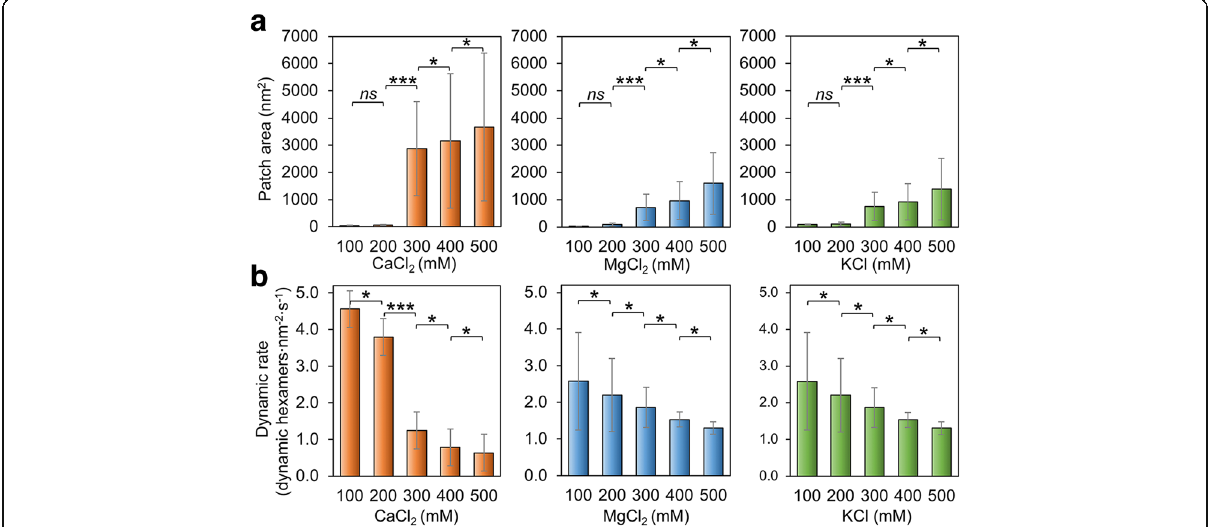
Fig. 3 Effects of salt concentration on the self-assembly of Hoch_5815. a The mean patch areas measured by AFM under a range of 100 – 500 mM CaCl 2 , MgCl 2 , and KCl ( n = 50). The rise in salt concentration resulted in increased patch sizes. Significant changes in patch area were observed between 200 and 300 mM (*** p < 0.001, * p < 0.05, ns not significant, two-way ANOVA). b The mean rates of dynamic events determined from high-speed AFM image series under a range of 100 – 500 mM CaCl 2 , MgCl 2 , and KCl ( n = 50). Each 100 mM change in salt concentration led to a significant change in the rate of dynamic events (*** p < 0.001, * p < 0.05, ns not significant, two-way